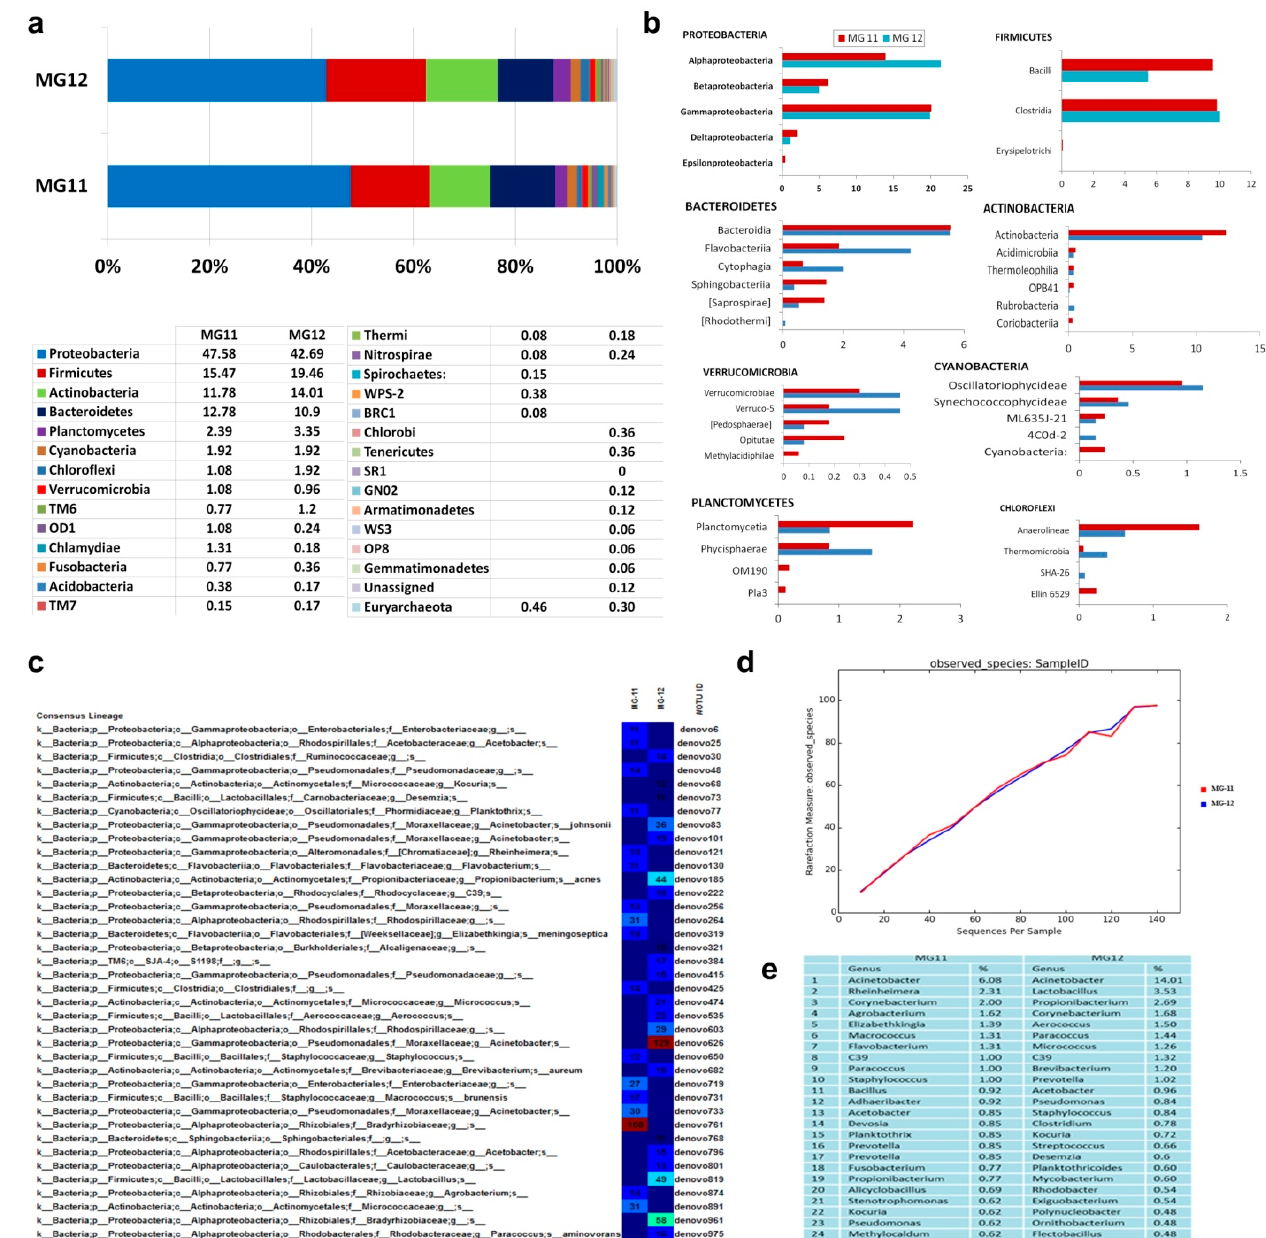
Figure 8. Images of 16S rRNA metagene V3–V4 region profiling with Illumina MiSeq NGS platform with 2 × 300 bp sequencing chemistry on grape callus “FC01”-derived DNA samples MG11 and MG12. ( a ) Distribution of OTUs under dif- ferent phyla in MG11 and MG12 samples after QIIME analysis-II (excluding the chloroplast, mitochondrial and unassigned sequences) displaying high extent of bacterial diversity, ( b ) Predominant Classes under different phyla in MG11 and MG12 samples, ( c ) OTU Consensus lineage for MG11 and MG12 samples, ( d ) Rarefaction plot, ( e ) Top 25 genera in MG11 and MG12 samples.